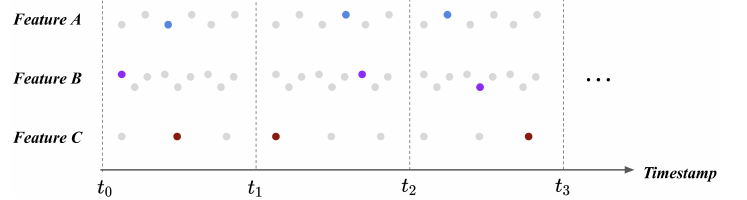
Figure 3. Flight logs after timestamp pooling. We selected a single representative value during the particular time window to make each feature includes the same number of value. The timestamp pooling transforms flight logs into the fixed-shape feature vector during a single time window; thus, the produced feature vectors can be provided to the